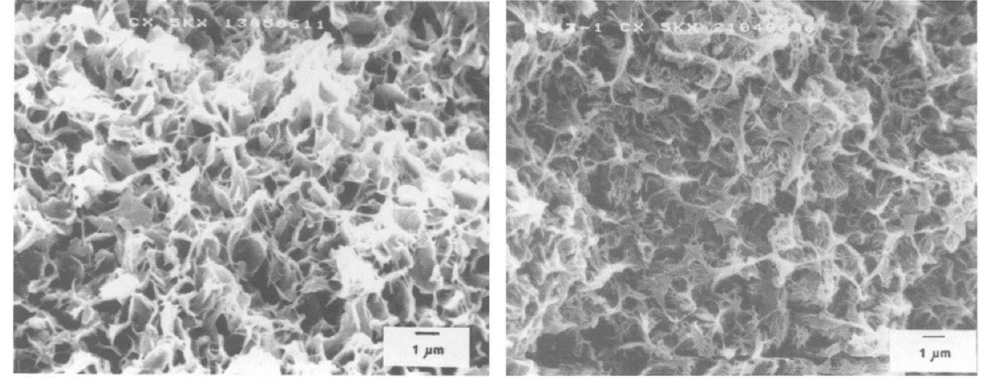
Figure 8. Scanning electron micrographs of the membrane structure resulting from the solid–liquid phase separation of HDPE in a mineral oil solution. The diluent was extracted with TCE from a 19 wt. % ( left ) or 34 wt. % ( right ) HDPE solution, adapted from [5] .